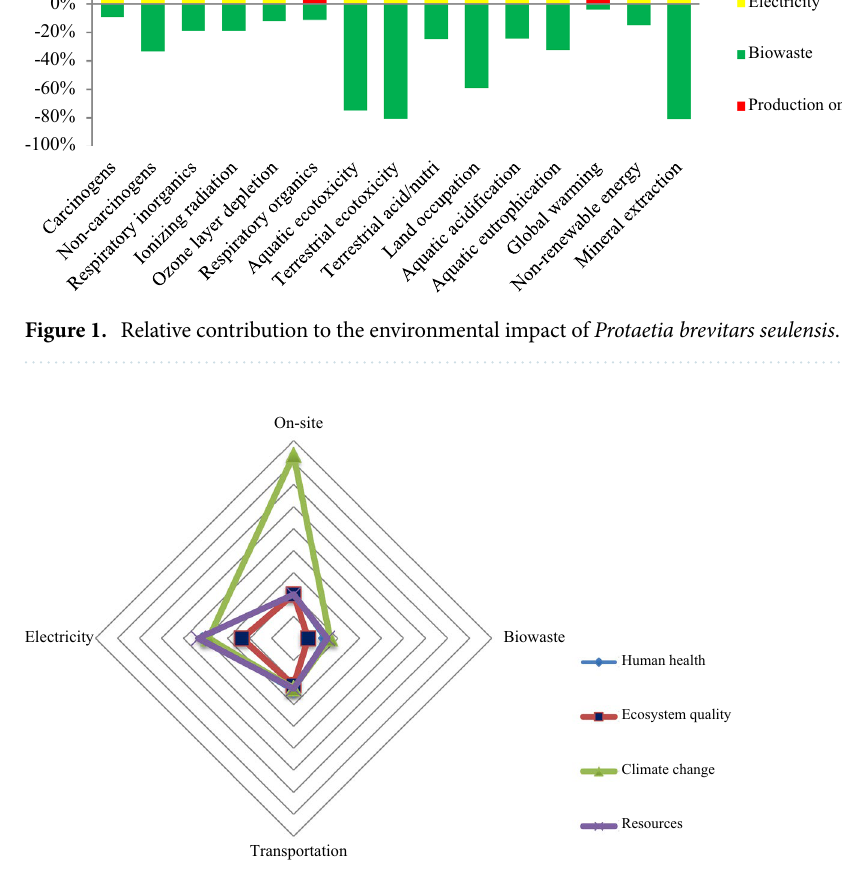
Figure 2. Normalized damage assessment of production system based on different consumption